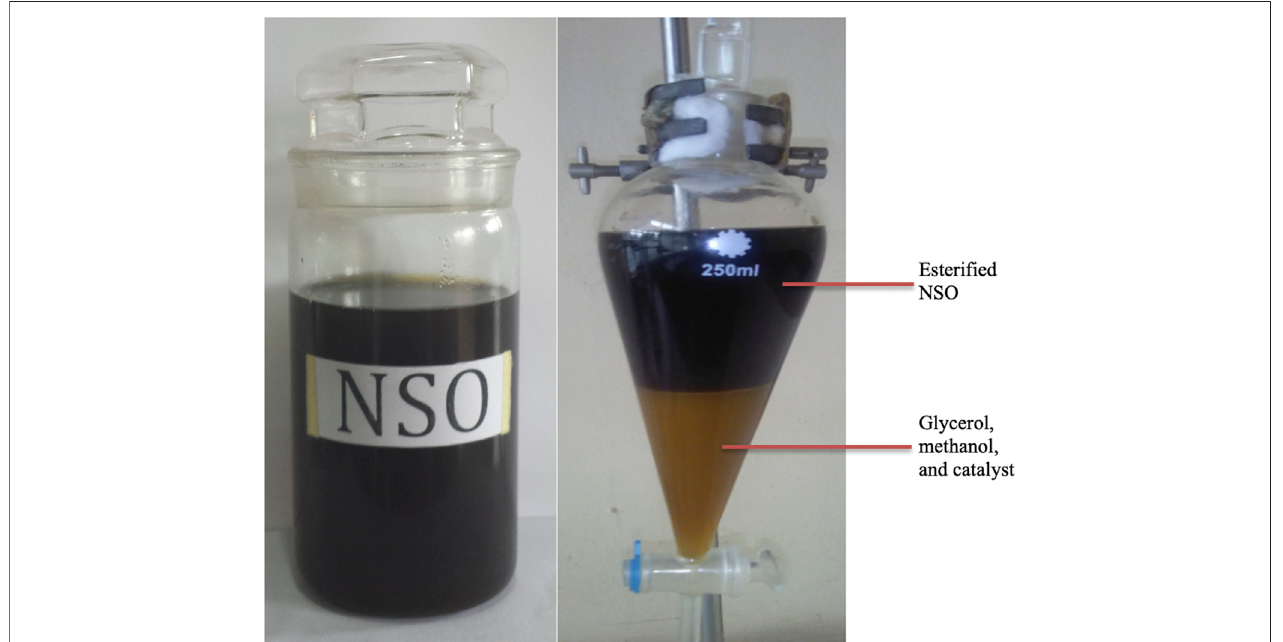
FIGURE 2 | NSO and separation of esteri fi ed NSO from byproducts.